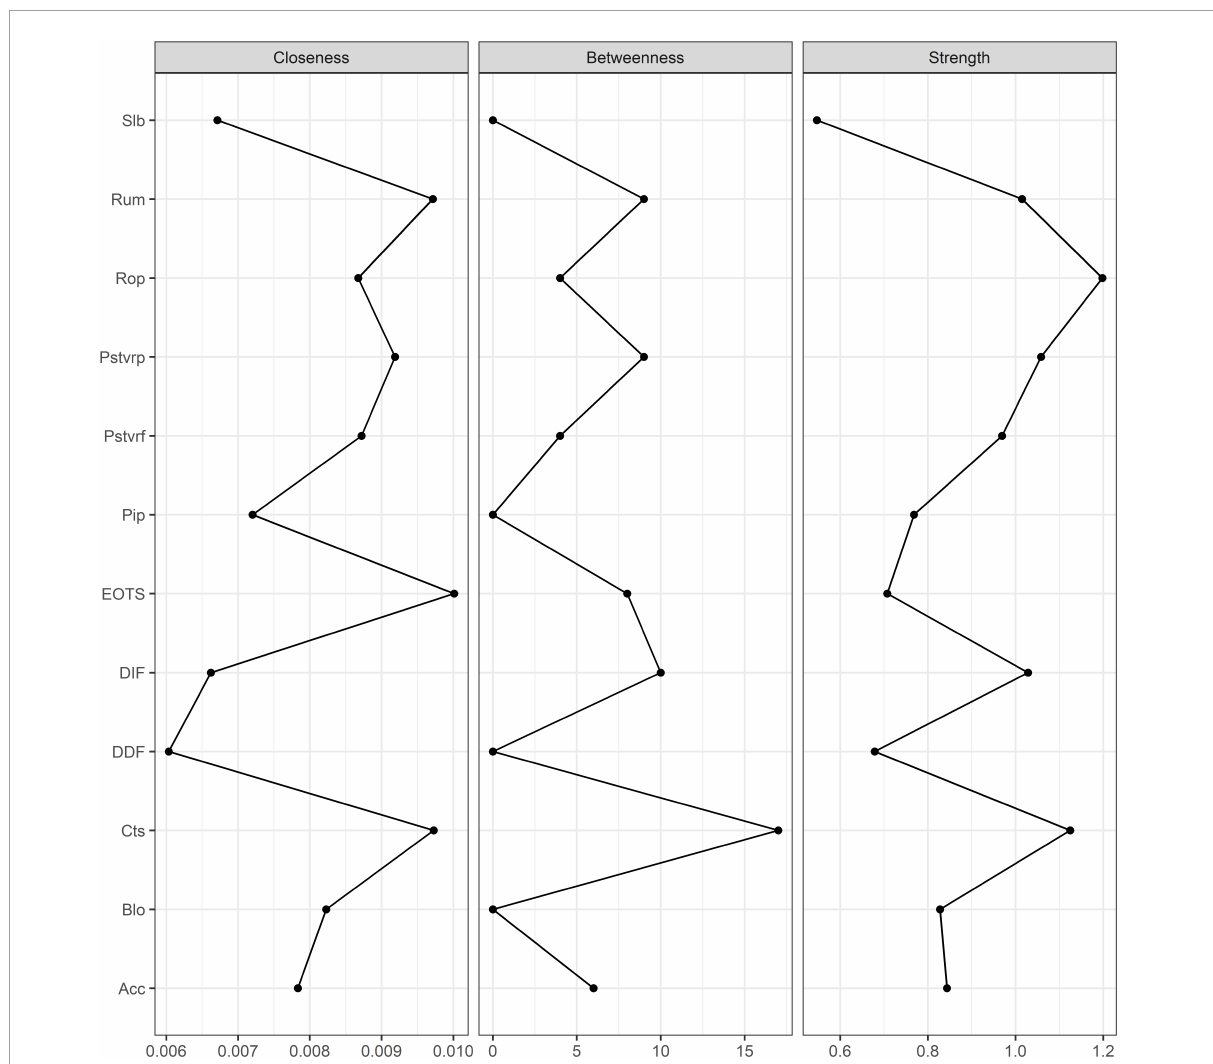
FIGURE2 Centrality plot for the regularized network. Strength measures the importance of nodes in a network. Closeness and Between measure the importance of nodes to the overall information transmission of the network. Slb, Self-blame; Acc, Acceptance; Rum, Rumination; Pstvrf, Positive refocusing; Rop, Refocusing on planning; Pstvrp, Positive reappraisal; Pip, putting into perspective; Cts, Catastrophizing; Blo, Blaming others; DIF, Difficulty Identifying Feelings; DDF, Difficulty Describing Feelings; EOTS, Externally-Oriented